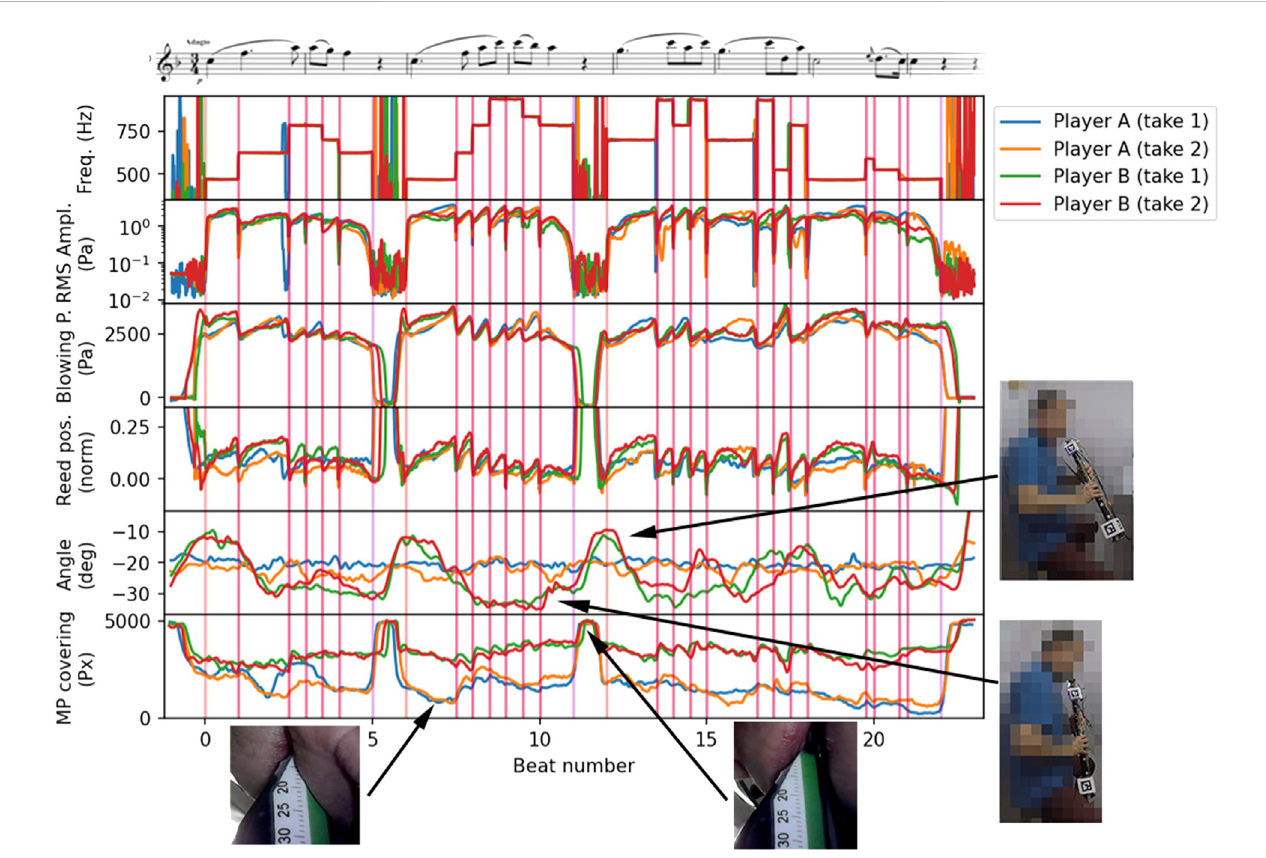
FIGURE 9 Example data from two expert clarinettists playing an excerpt from Mozart ’ s Clarinet Concerto (two takes by each player). Images are pixelated to preserve player anonymity. The toptwo graphs show thefundamental frequency inHzandtheRMS amplitude ofthesoundinside themouthpiece inpascals. The third shows the blowing pressure inside the mouth, measured in pascals. The fourth shows the DC component of the normalised distance between reed and mouthpiece with a larger value indicating a larger aperture. The fi fth shows the relative angle between the head and the instrument, in degrees. The sixth shows the amount of mouthpiece (MP) covered by the lips i.e., the unobscured green area in pixels, indicating lip